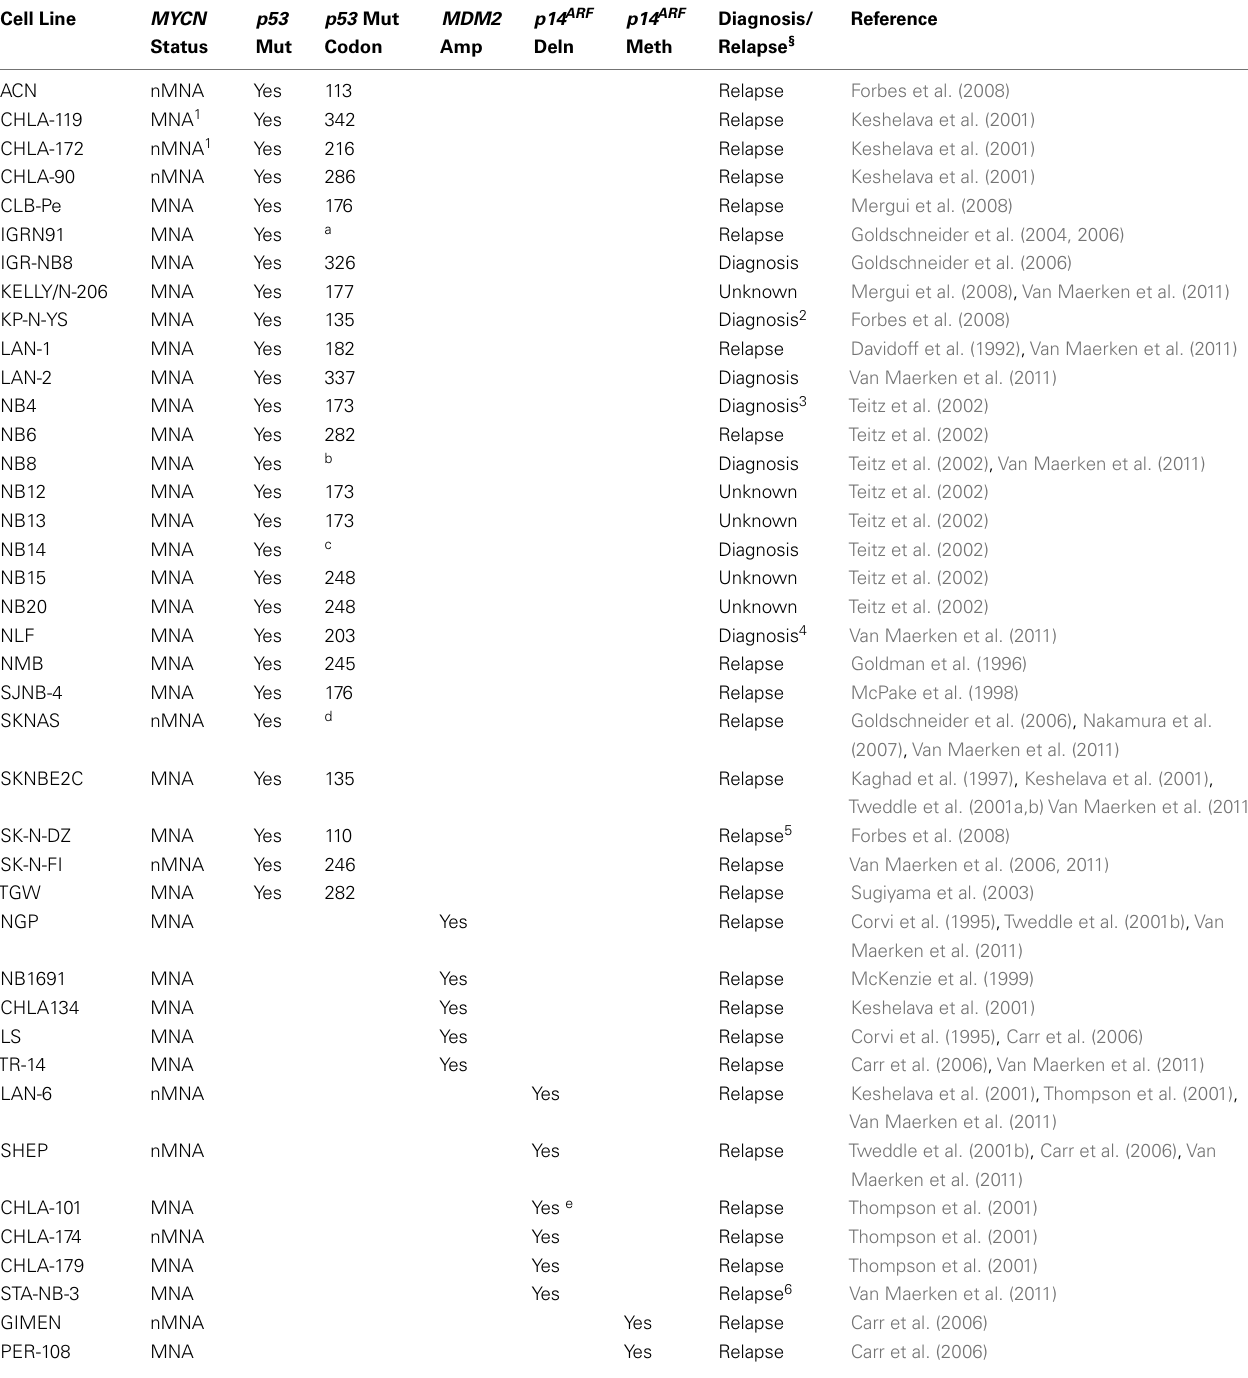
Table 1 | MYCN status and aberrations in the p53/MDM2/p14 ARF pathway in neuroblastoma cell